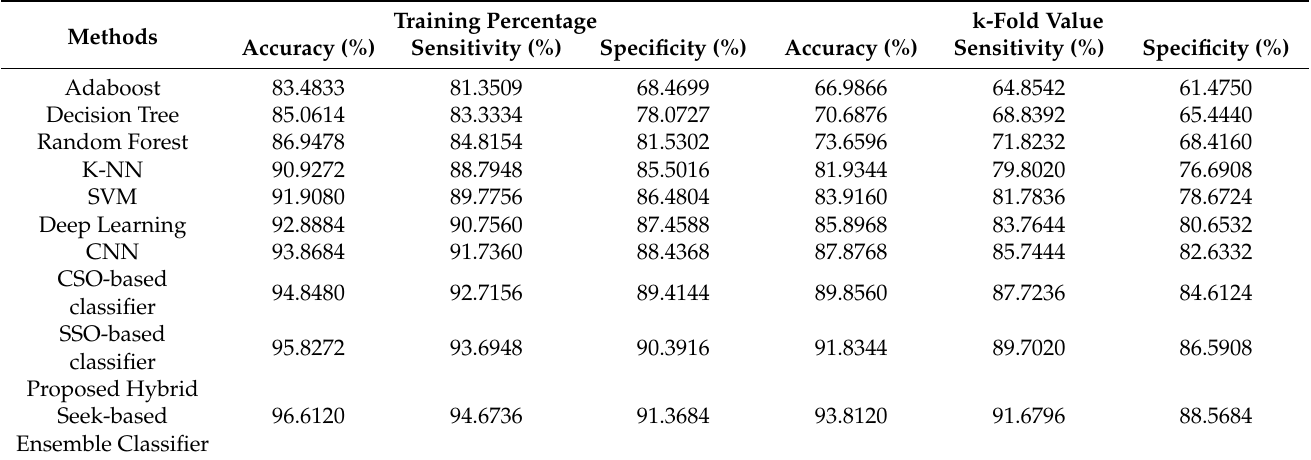
Table 2. Comparison of methods using the CHB-MIT database.